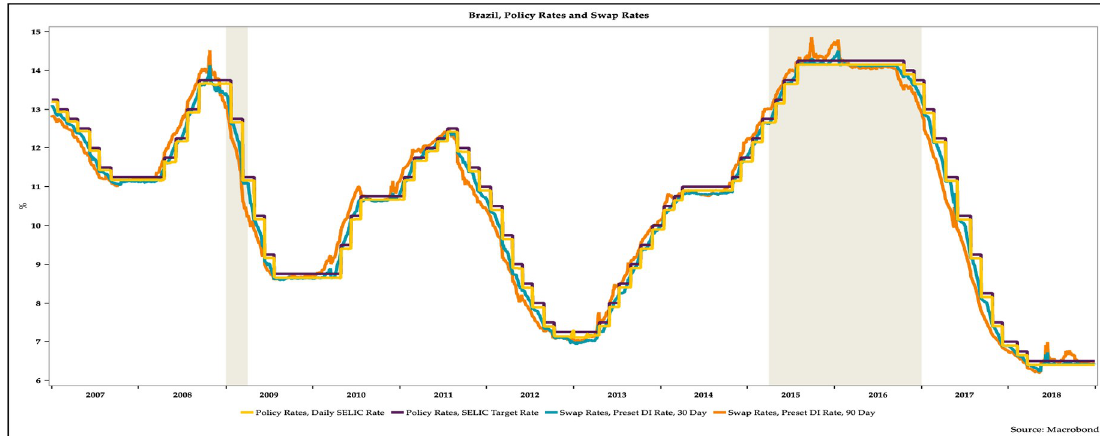
Fig 2. The evolution of policy rates and swap rates in Brazil,